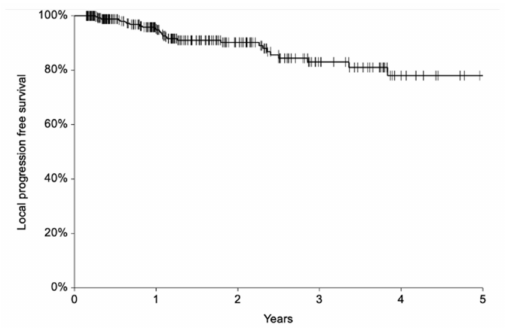
Figure 2. Local progression-free